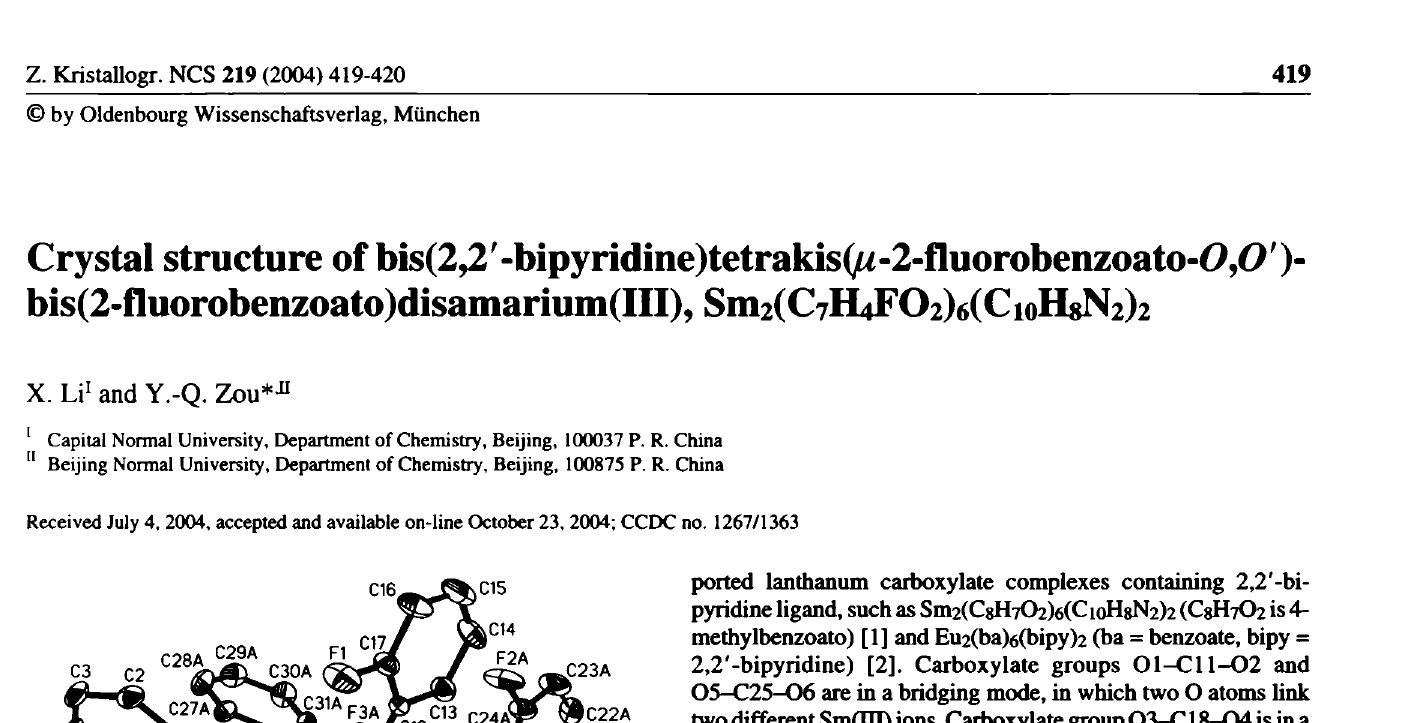
Table 1. Data collection and handling.